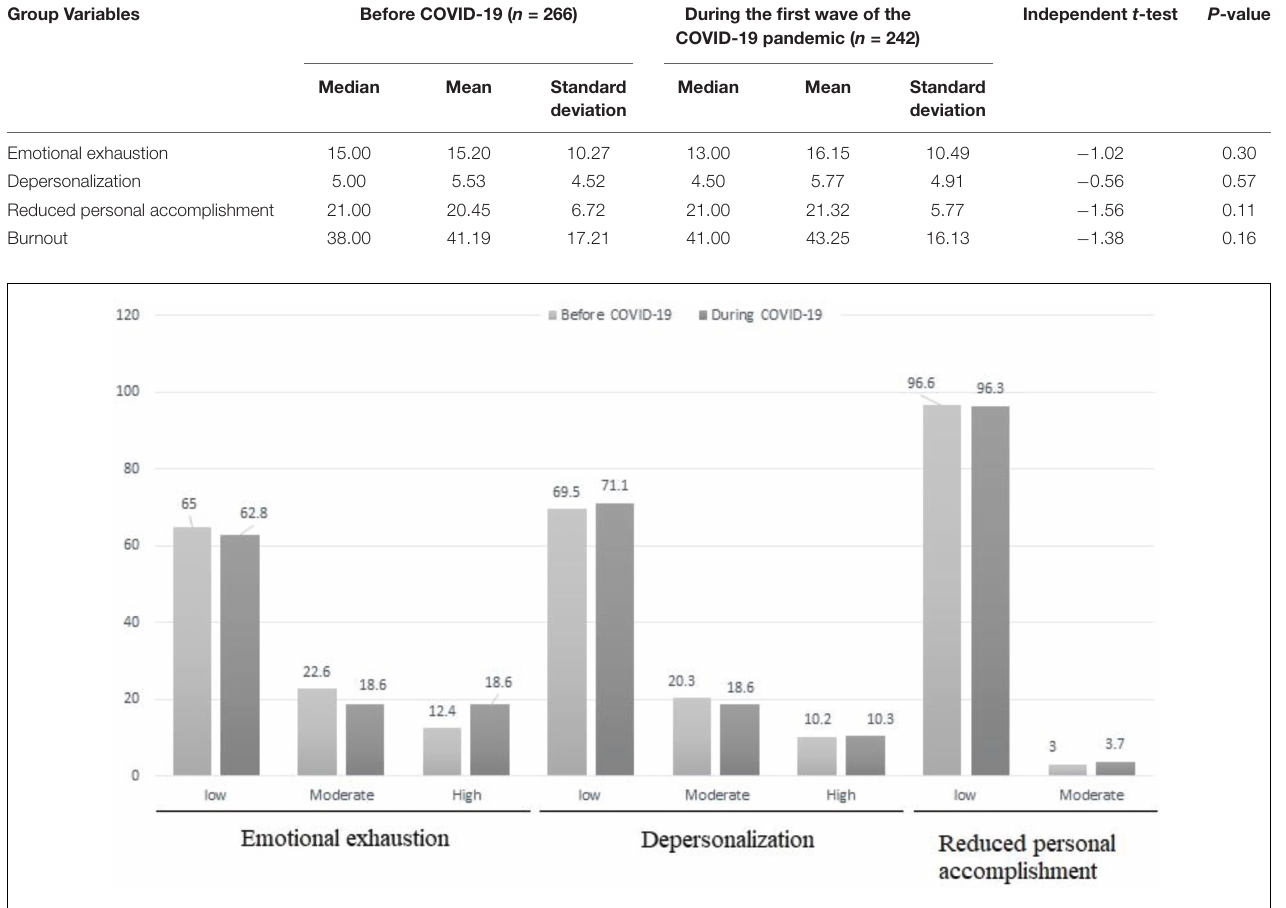
TABLE 2 | Comparison of the burnout scores before and during the first wave of the COVID-19 pandemic. Group Variables Before COVID-19 ( n = 266) During the first wave of the